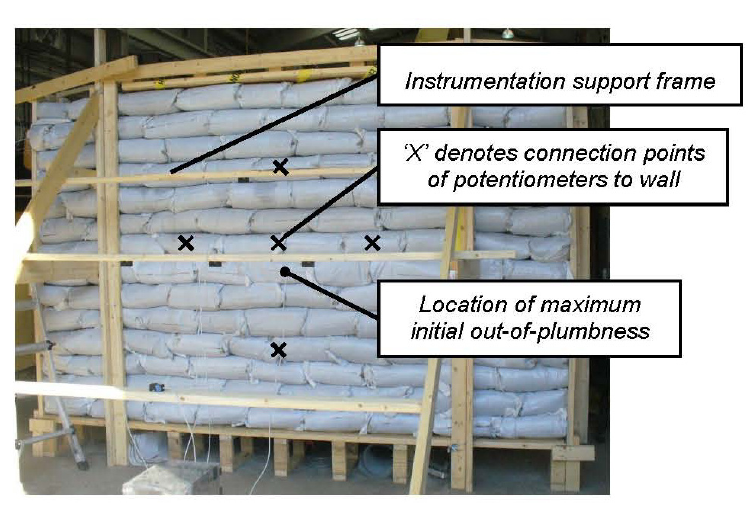
Figure 5. Completed test wall and